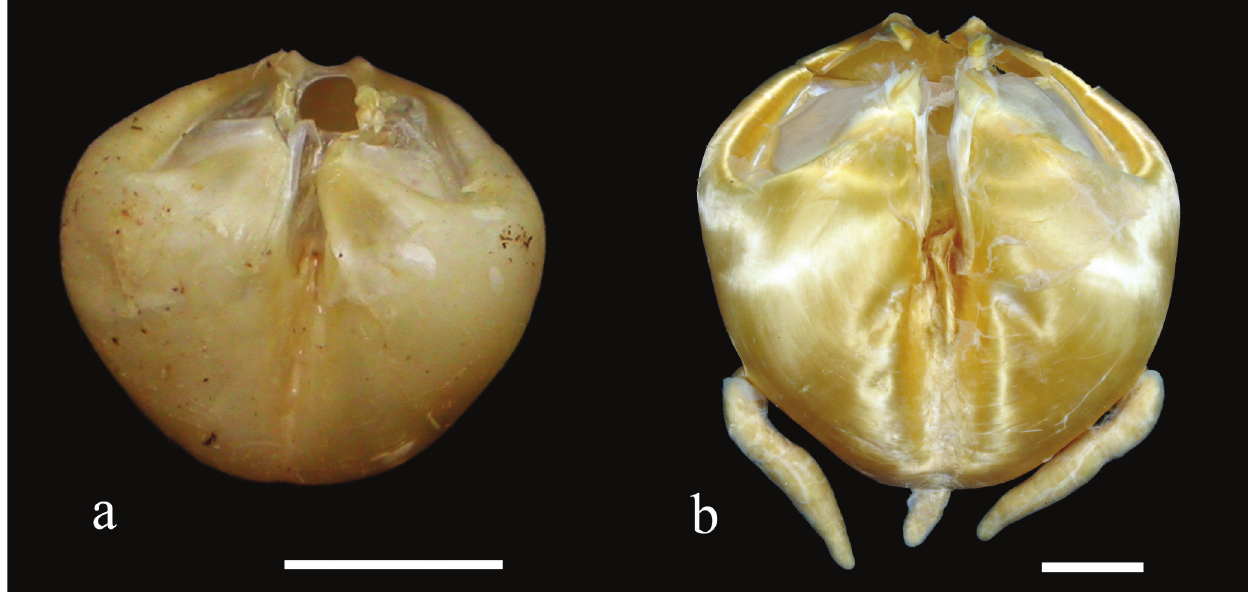
Fig. 2. Dorsal view of gas bladder of Trachycorystes menezesi , new species ( a ), and Trachycorystes trachycorystes ( b ). Scale bar = 10